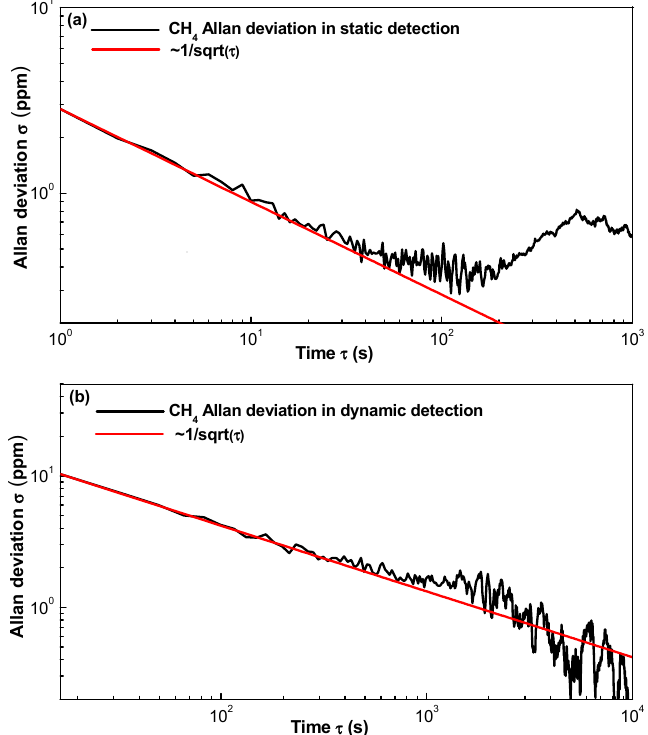
Figure 12. Allan deviation plot of the CH 4 sensor in ( a ) static state with a sampling interval of 1 s and ( b ) dynamic state with a sampling interval of 10 s.